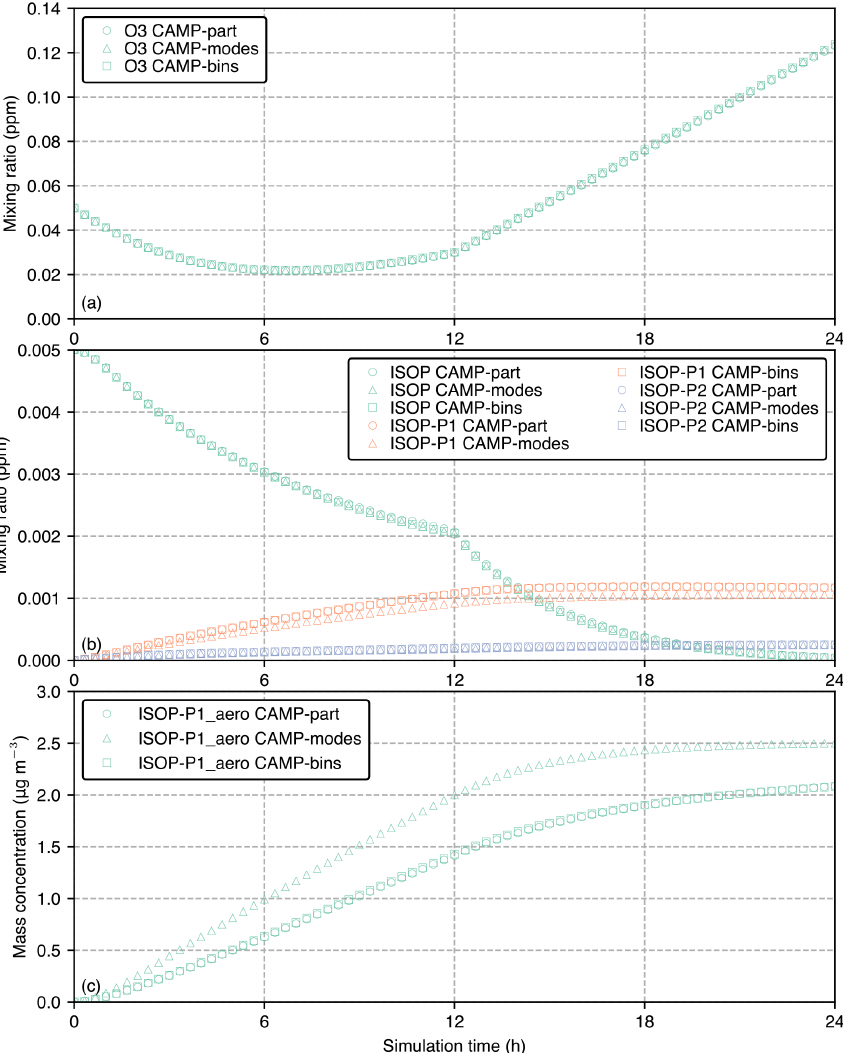
Figure 8. Comparison between CAMP-modes, CAMP-bins, and CAMP-part for (a) ozone mixing ratio, (b) ISOP, ISOP-P1 and ISOP-P2 mixing ratios, and (c) ISOP-P1_aero mass concentration for the 24h simulation